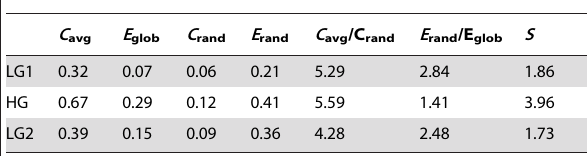
Table 1. Table of small-world-ness